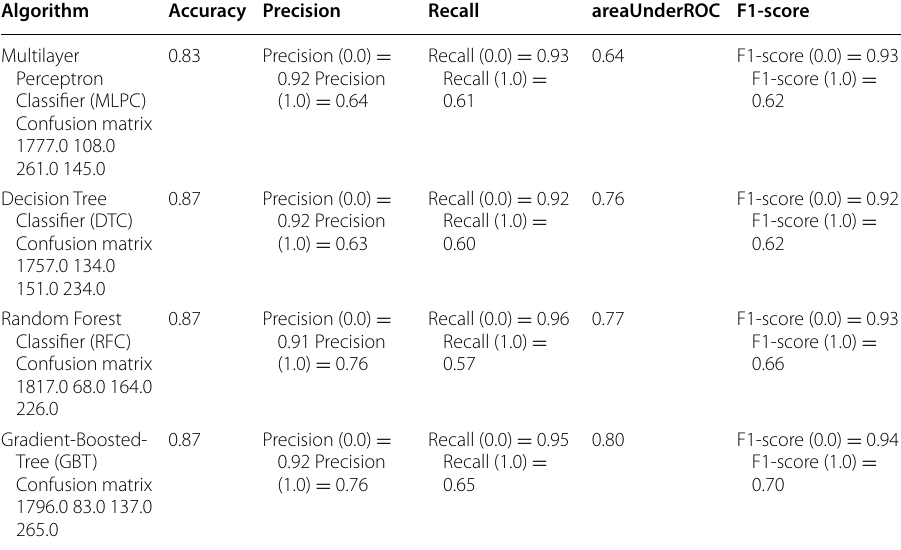
Table 14 Comparison of binary classes